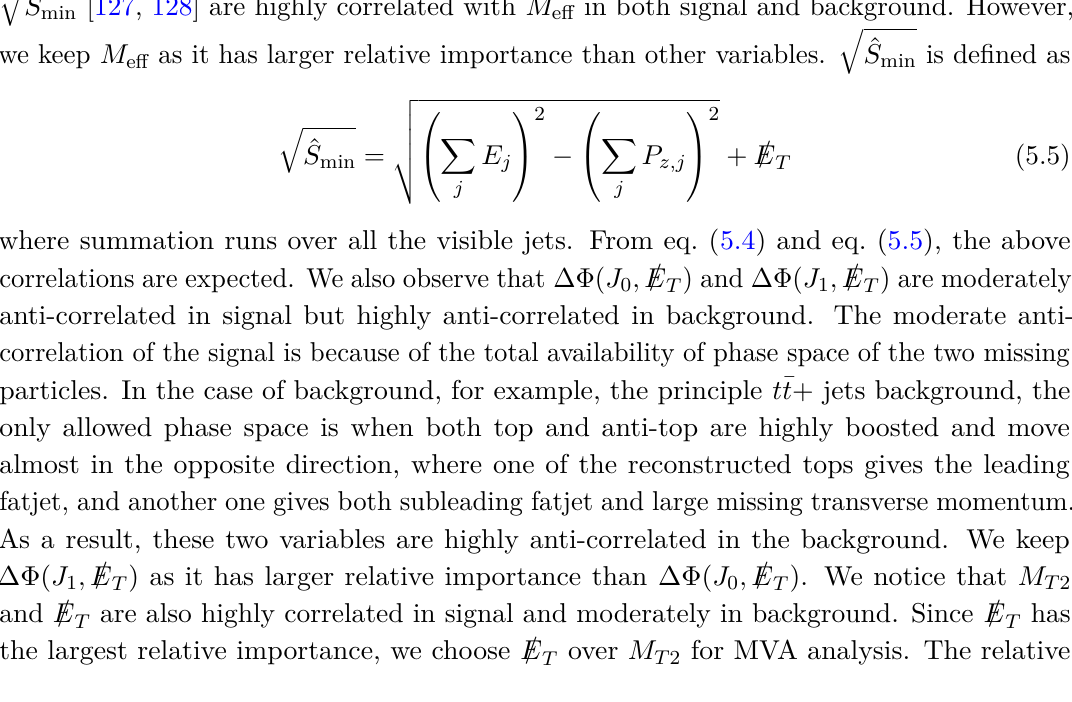
Signal (test sample) Background (test sample)